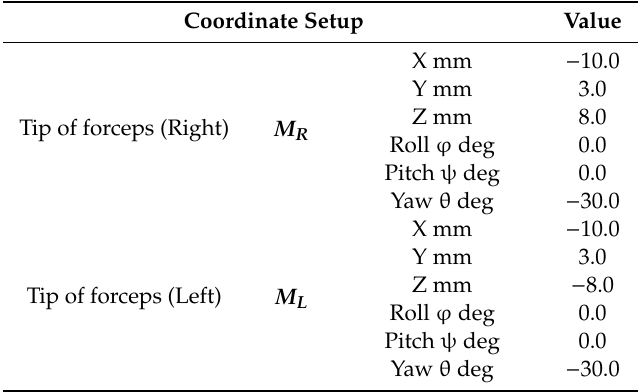
Table 2. Initial setup of forceps